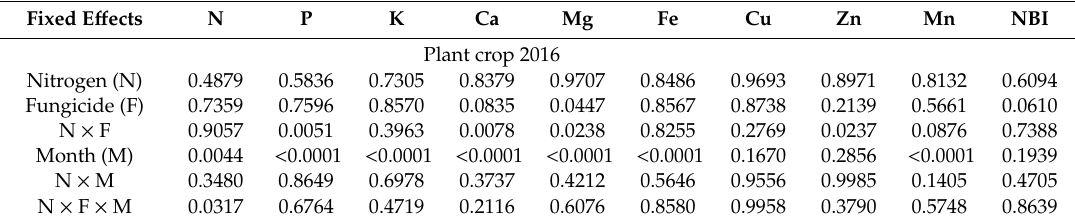
Table 2. Repeated measures analyses ANOVA p -values for the e ff ects of nitrogen, fungicides, sampling months, and their interactions on sugarcane leaf tissue nutrient composition of 2016 plant